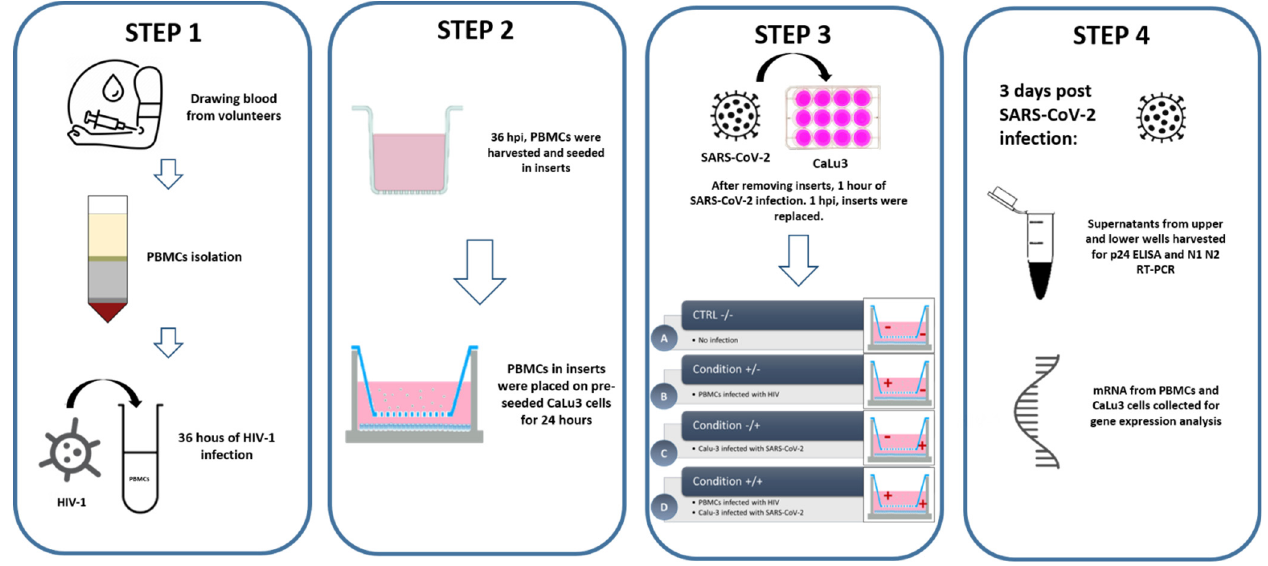
Scheme 1. Experimental design of the in vitro coinfection